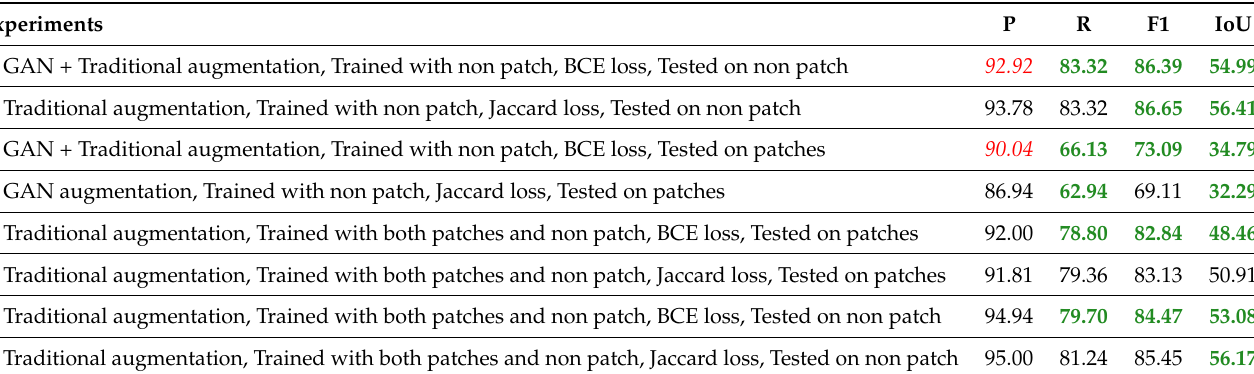
Table 9. Best SegNet scenarios in eight